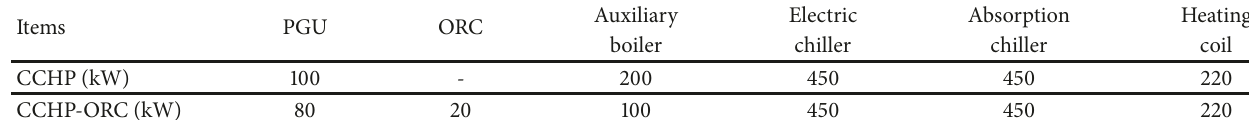
Table 3: Equipment’s capacities.